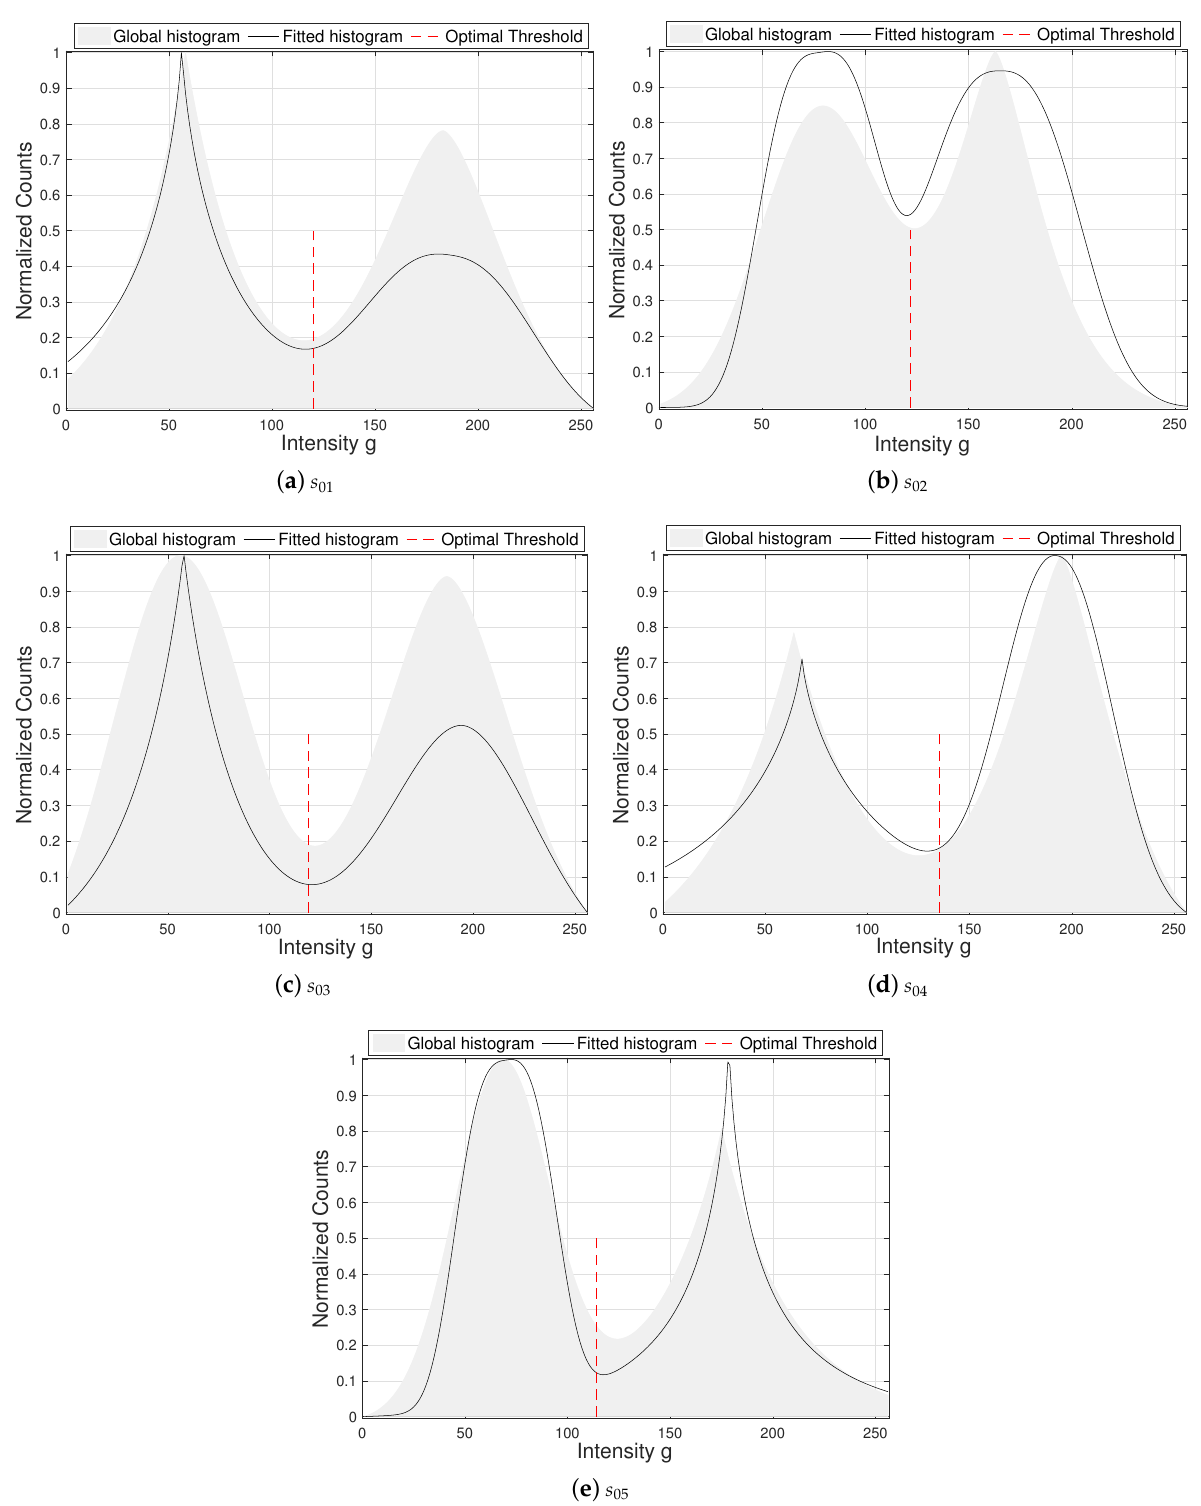
Figure 3. Cases of fitted histograms utilizing the thresholding method based on Cuckoo Search Algorithm. The reference distribution is depicted with a red dashed